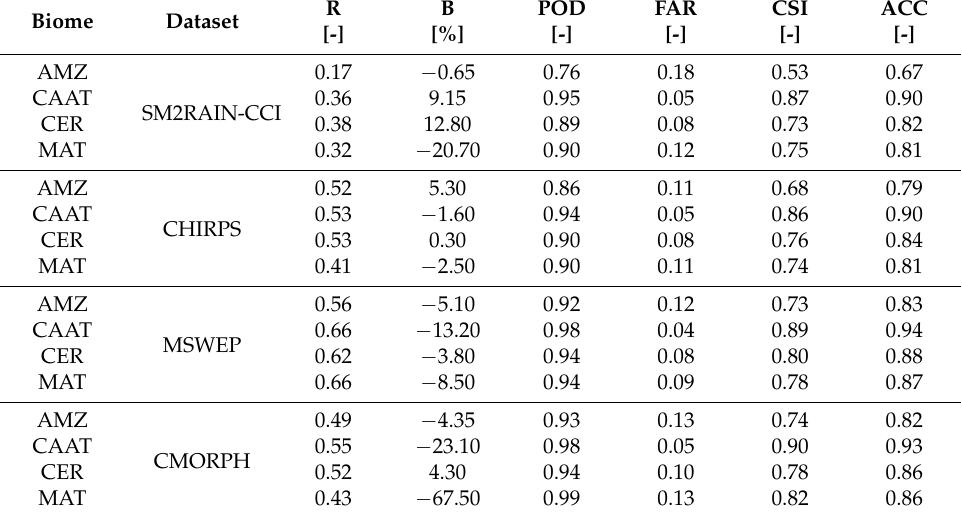
Table 12. Comparison among correlation coefficient (R), percent bias (B), probability of detection (POD), false alarm ratio (FAR), critical success index (CSI), and accuracy (ACC) for the daily rainfall estimates derived from SM2RAIN-CCI, CHIRPS, MSWEP, and CMORPH against observations from the GBGR data over the biomes of NEB. For each score, the median value is